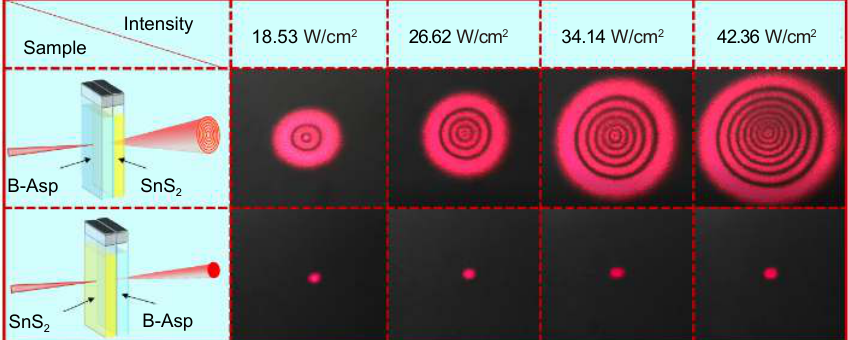
Fig. 6 | The unidirectional nonlinear excitation in 2D B-AsP/ SnS 2 hybrid structure to achieve the spatial asymmetric light